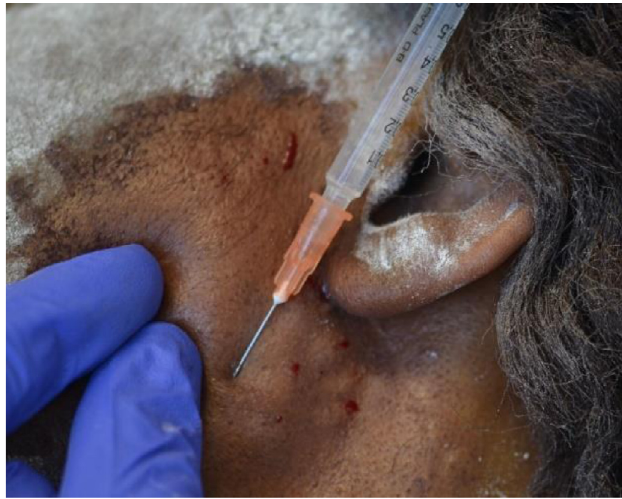
Fig. 6. A 36-year-old patient after total parotidectomy for a pleomorphic adenoma. Multiple injections (credit: Dr.